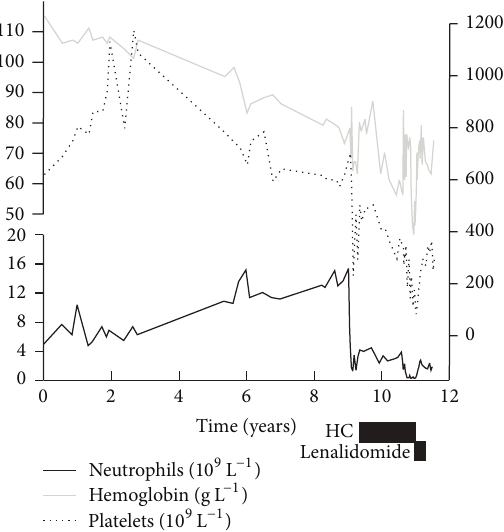
Figure 1: Table demonstrating neutrophil count, platelet count, and pretransfusion hemoglobin against time from diagnosis up until the time of transplant, also showing the effect of hydroxycarbamide and lenalidomide on these.